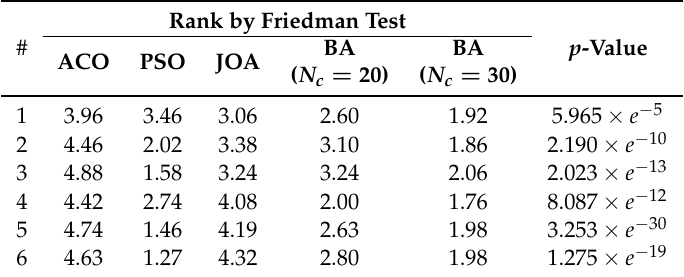
Table 3. Ranking by Friedman test for each scenario in the first